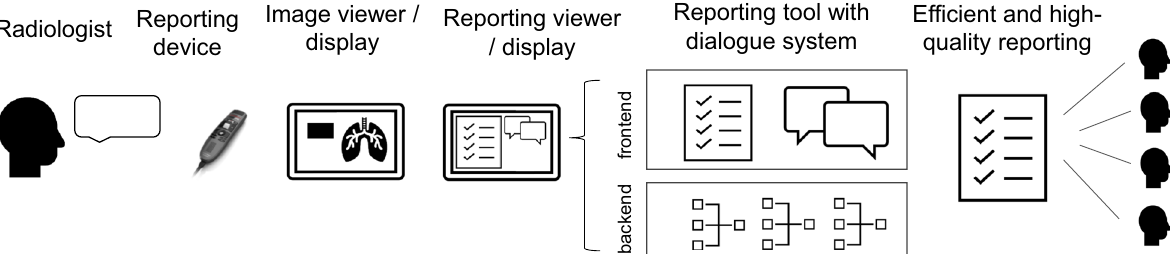
Fig. 1 Graphic representation of the reporting workflow using the reporting tool. Reporting is done as free text using speech recognition. The reporting tool comprises a user interface (frontend), and a dialogue system that enables NLP-based conversion of free text into a structured report and communication with the radiologist (backend). The combination of these components enables efficient and high-quality